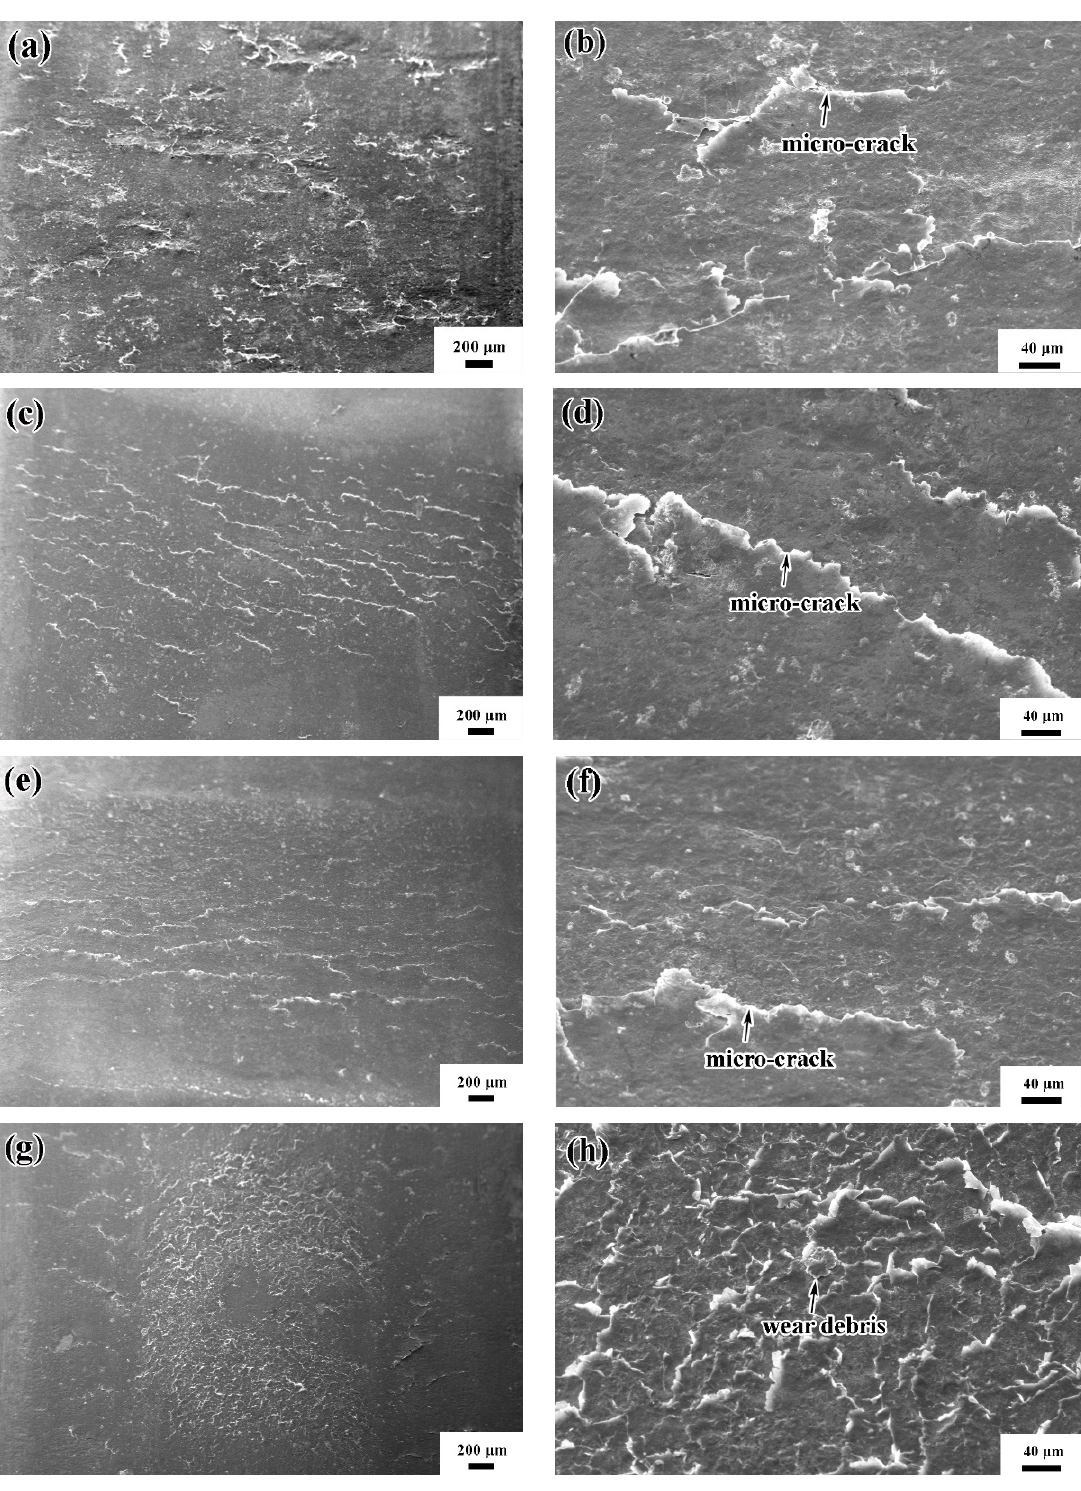
Figure 8. Worn surface of 1280G rail steel under different rolling cycles. ( a , b ) 1.0 × 10 5 cycles; ( c , d ) 2.5 × 10 5 cycles; ( e , f ) 5.0 × 10 5 cycles; ( g , h ) 7.5 × 10 5 cycles.